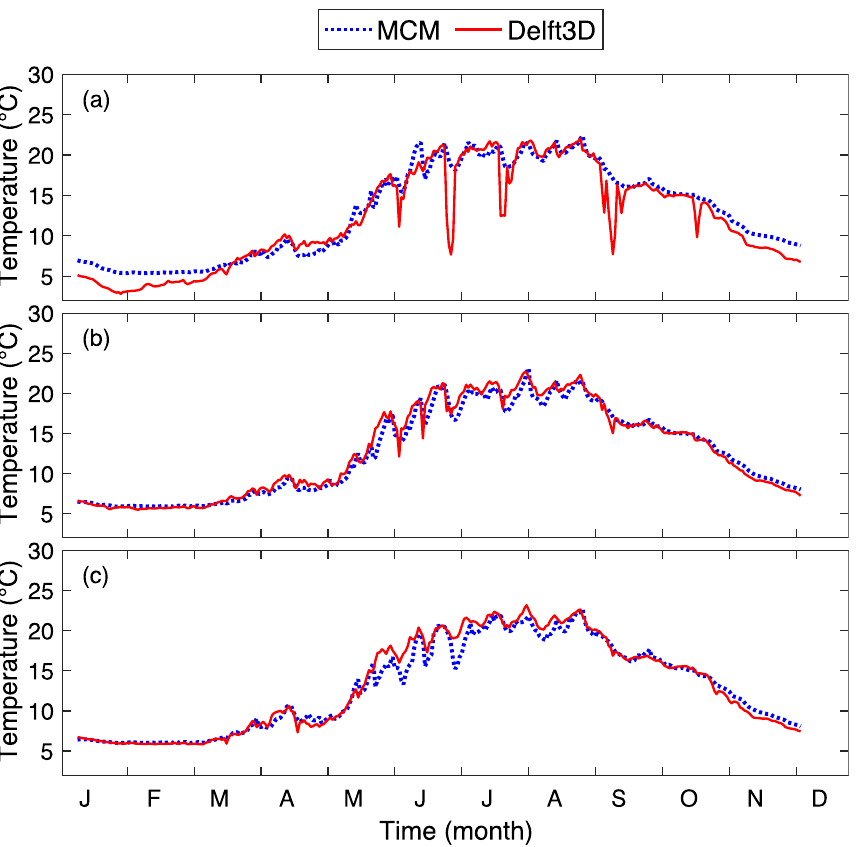
Figure 2. Surface water temperature from the MCM and Delft3D at points ( a ) P1, ( b ) P2, and ( c ) P3 (See map in Fig. 1). Plots generated with Matlab 25 ; Panels assembled with Adobe Illustrator 26